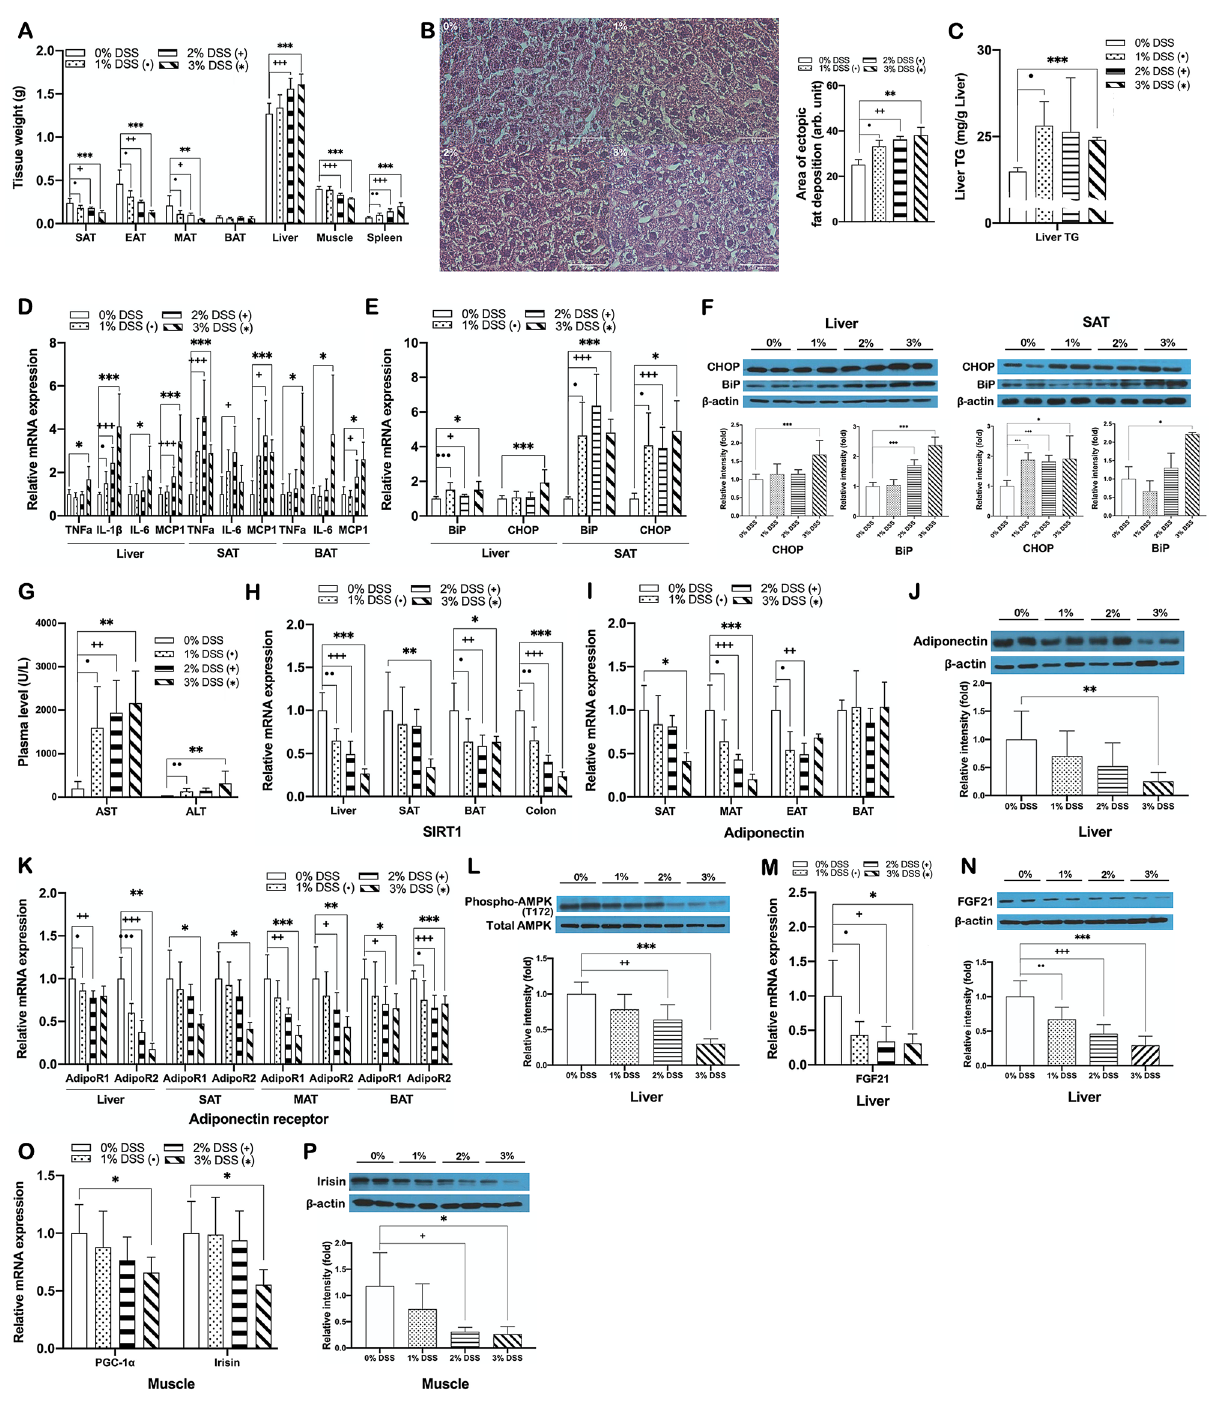
Figure 2. DSS-induced colitis is associated with hepatic steatosis in mice. ( A ) Tissue weights of DSS-induced colitis and non-colitis mice ( B ) Representative images of H&E staining of liver sections (left, ×400; scale bar, 50 μm) and a graph presenting area of ectopic fat deposition (right). ( C ) Hepatic TG content. mRNA expression of ( D ) pro-inflammatory cytokines in the liver, SAT, and BAT, and ( E ) ER stress-related markers in the liver and SAT, ( H ) SIRT1 in the liver, SAT, BAT, and the colon, ( I ) adiponectin in adipose tissues, ( K ) adiponectin receptors in the liver and adipose tissues, ( M ) FGF21 in the liver, and ( O ) PGC-1α and irisin in skeletal muscle of DSS-induced colitis and non-colitis mice. Gene expression levels are normalized to GAPDH or Arbp expression. Protein expression of ( F ) CHOP and BiP in the liver and SAT, ( J ) adiponectin in SAT, ( L ) phosphorylated and total AMPK in the liver, ( N ) FGF21 in the liver, and ( P ) irisin in skeletal muscle of DSS-treated and non-treated mice. ( G ) Plasma levels of AST and ALT in DSS-induced colitis and non-colitis mice. Data present mean ± SD for 5–8 mice in each group. Student’s two-tailed t-test was used for the analysis of differences between experimental groups. •,+, * p < 0.05, ••,++, ** p < 0.01, •••,+++, *** p < 0.001. SAT, MAT, EAT, and BAT, subcutaneous, mesenteric, epididymal, and brown adipose tissue,